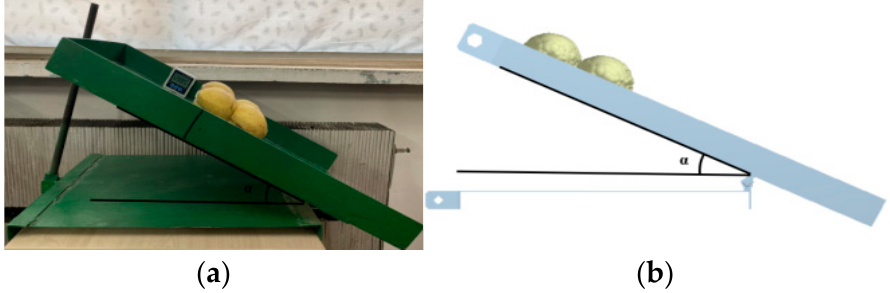
Figure 5. Calibration experiment of static friction coefficient between pears and materials. Physical experiment ( a ); Simulation experiment ( b ).